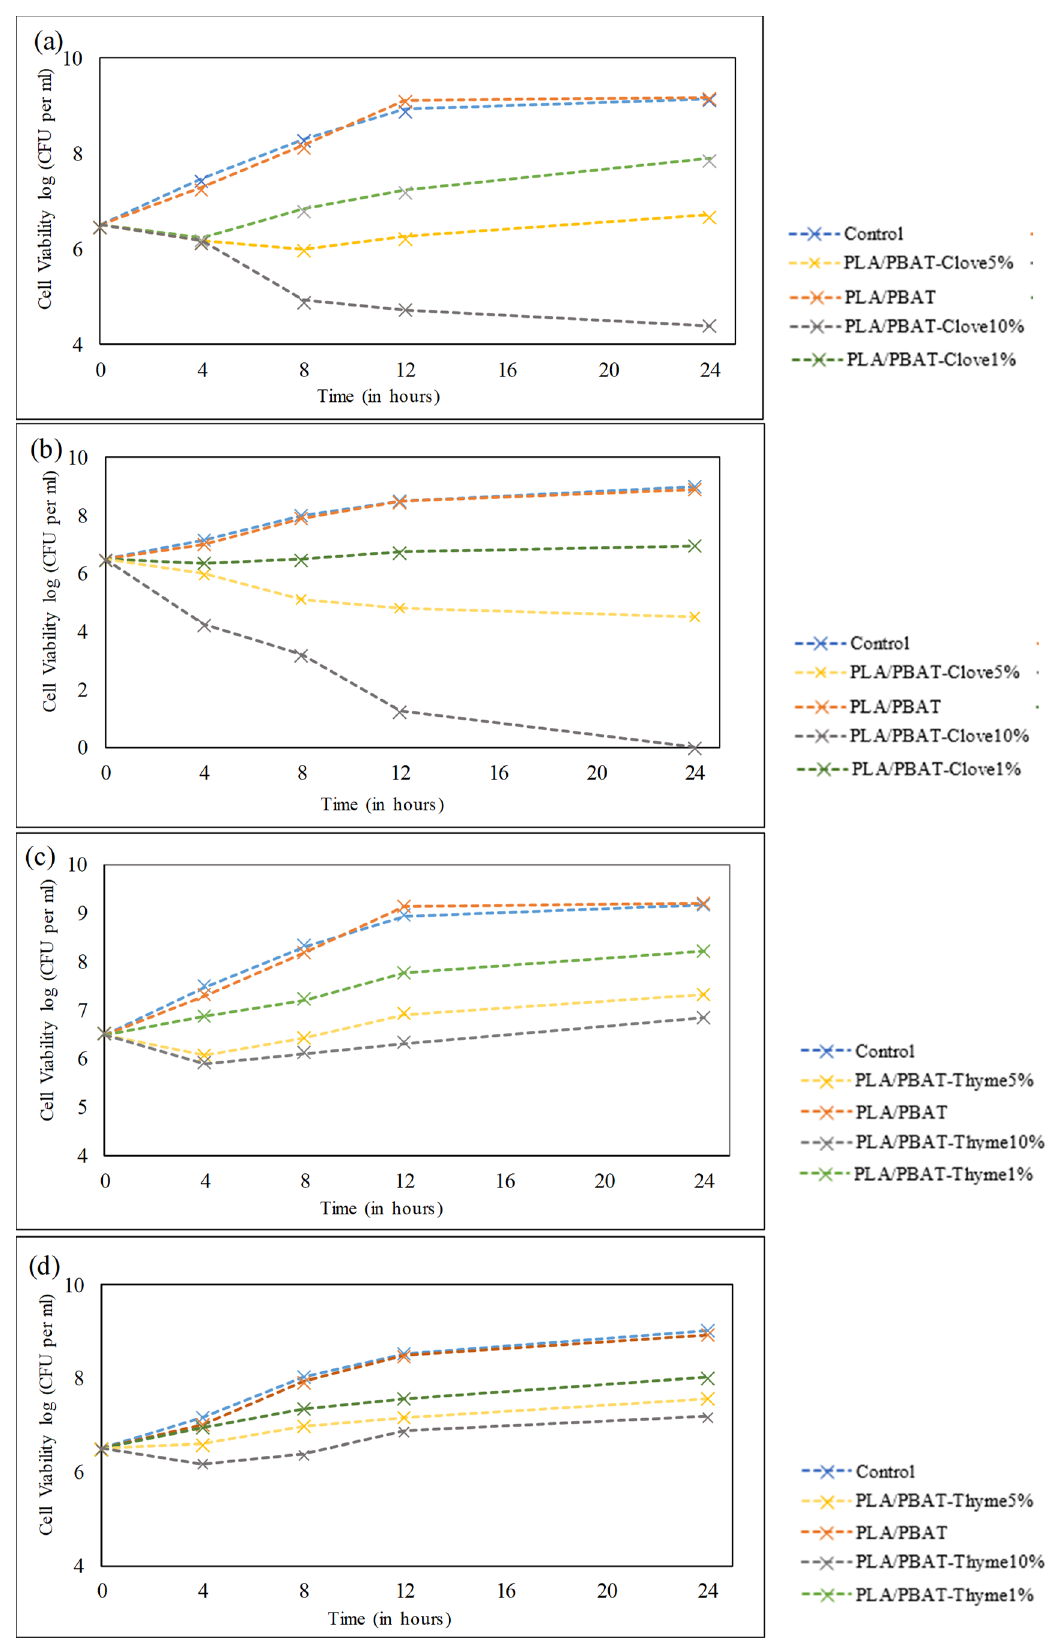
Figure 3. Antimicrobial efficiency of composite film. ( a ) effect of clove oil composite film on E. coli , ( b ) effect of clove oil composite film on S. aureus ( c ) effect of thyme oil composite film on E. coli and ( d ) effect of thyme oil composite film on S. aureus.